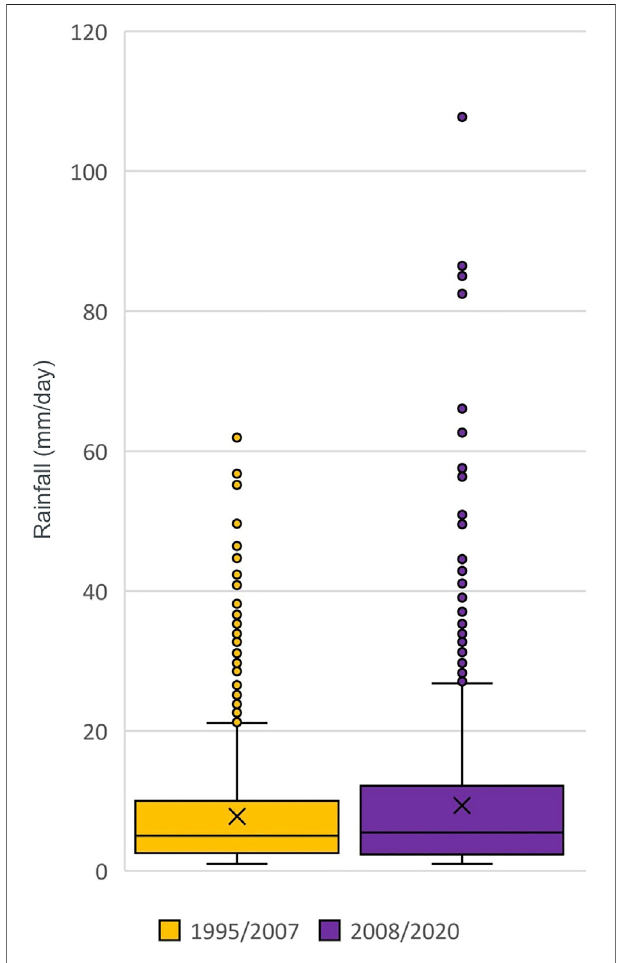
FIGURE 11 | Box and Whisker plot distribution of daily rainfall events calculated for the 1995 – 2007 subperiod (yellow box) and 2008 – 2020 subperiod (purple